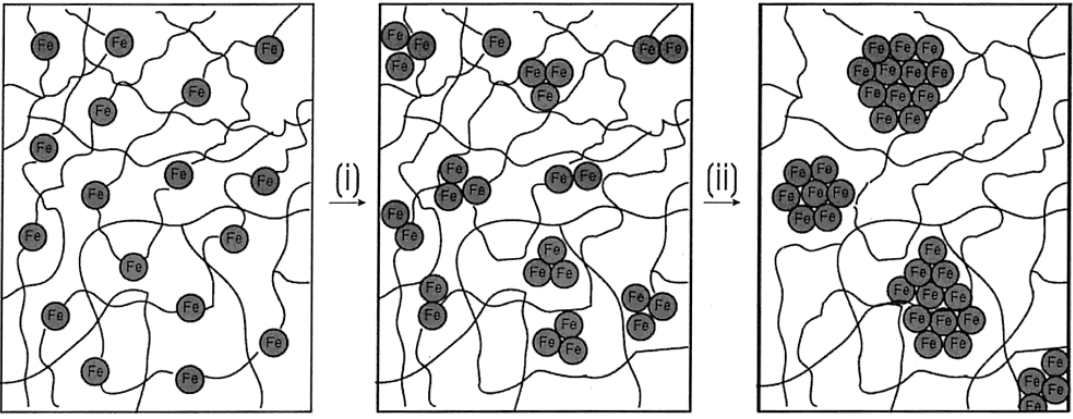
Figure 7. Representation of a nucleation and growth model that illustrates the genesis of the magnetic ceramic 10N from (i) the iron atom release from polymer 8B followed by (ii) nucleation and growth of iron nanoparticles. Reproduced from Ref. [68] with permission from American Chemical